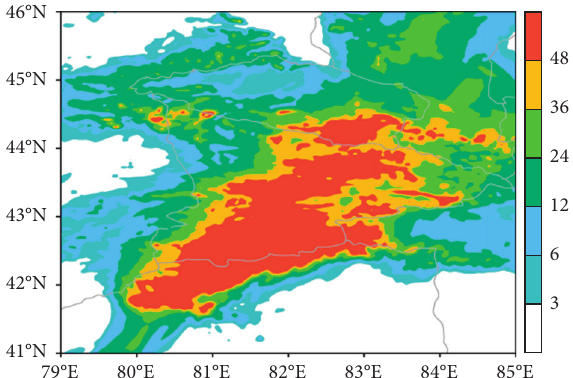
Figure 4: The total rainfall amounts simulated from 12:00 on July 31 to 12:00 on August 1, 2016 (shadow; unit,